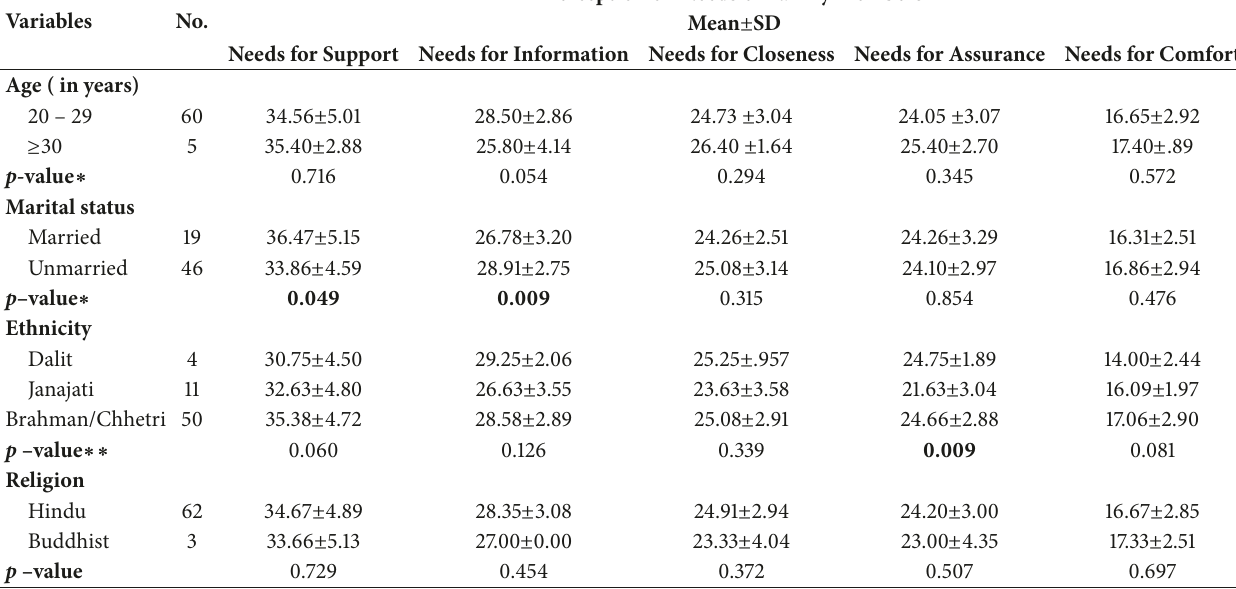
Table 6: Differences on perception of nurses on needs of family members according to sociodemographic variables. Variables